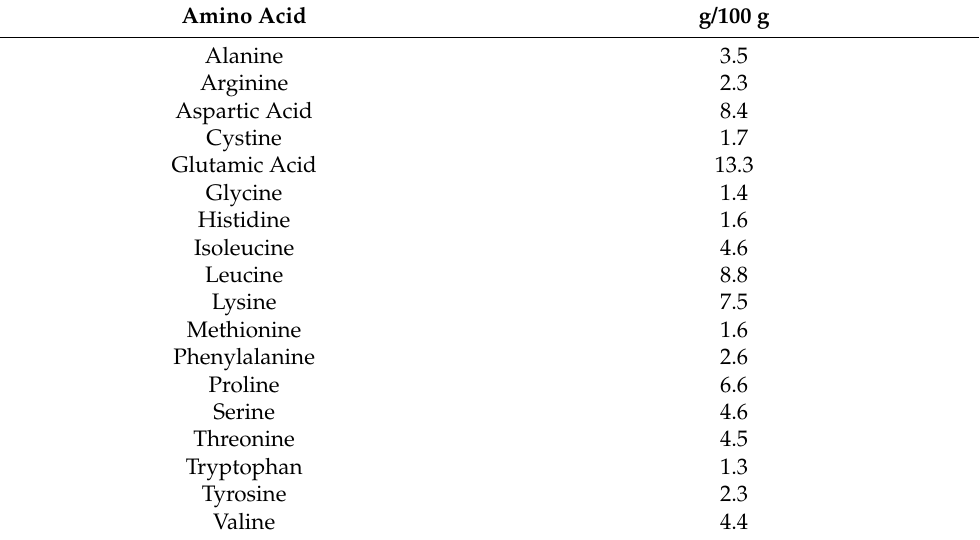
Table 1. Amino acid composition of whey protein supplement (Supplementary